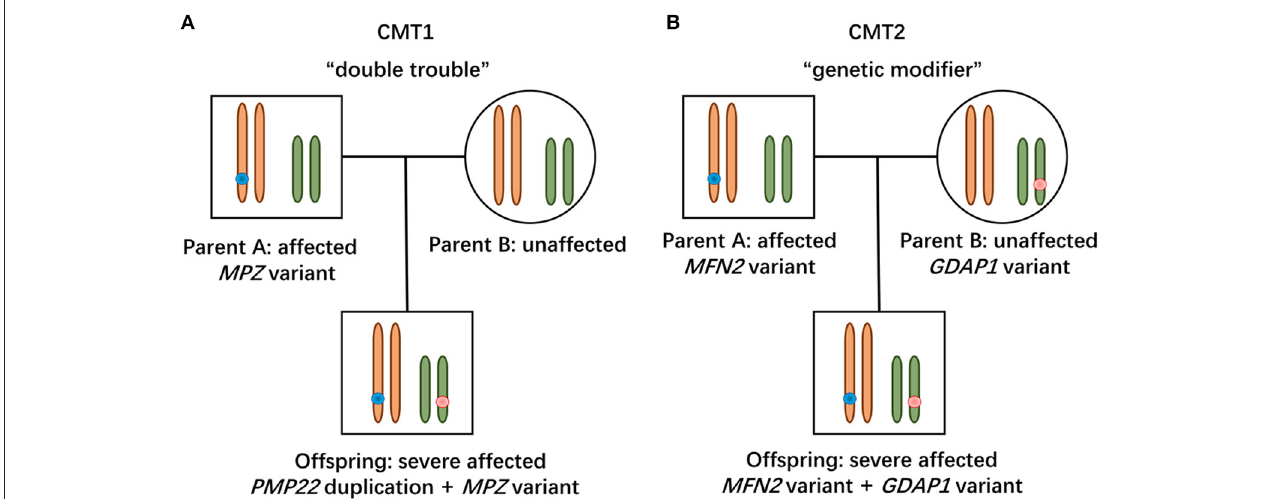
FIGURE 2 | Modes of concomitant variants in CMT. (A) Patient with CMT1 harboring de novo PMP22 duplication and inherited MPZ variant presented with a severe phenotype, suggesting a “double trouble” effect. (B) CMT2 patients possessing concomitant variants in MFN2 and GDAP1 were severely affected, indicating that the heterozygous state of GADP1 variants serves as a “genetic